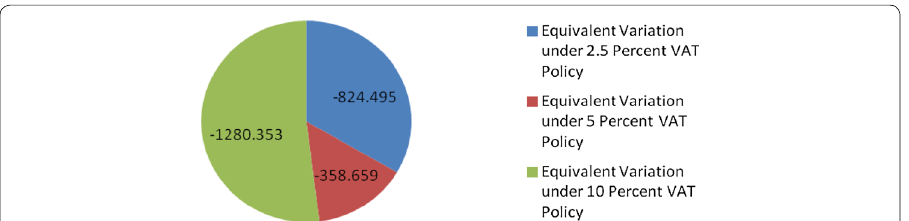
Fig. 13 Equivalent variation across household over the 10-year period